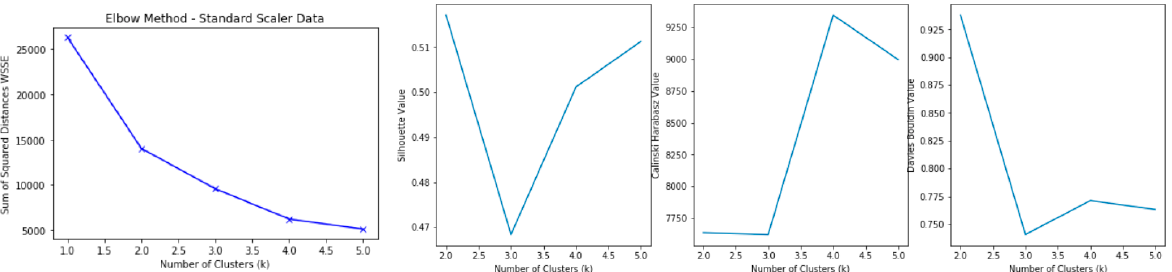
Figure 13. Metrics change for the standard-scaled data .